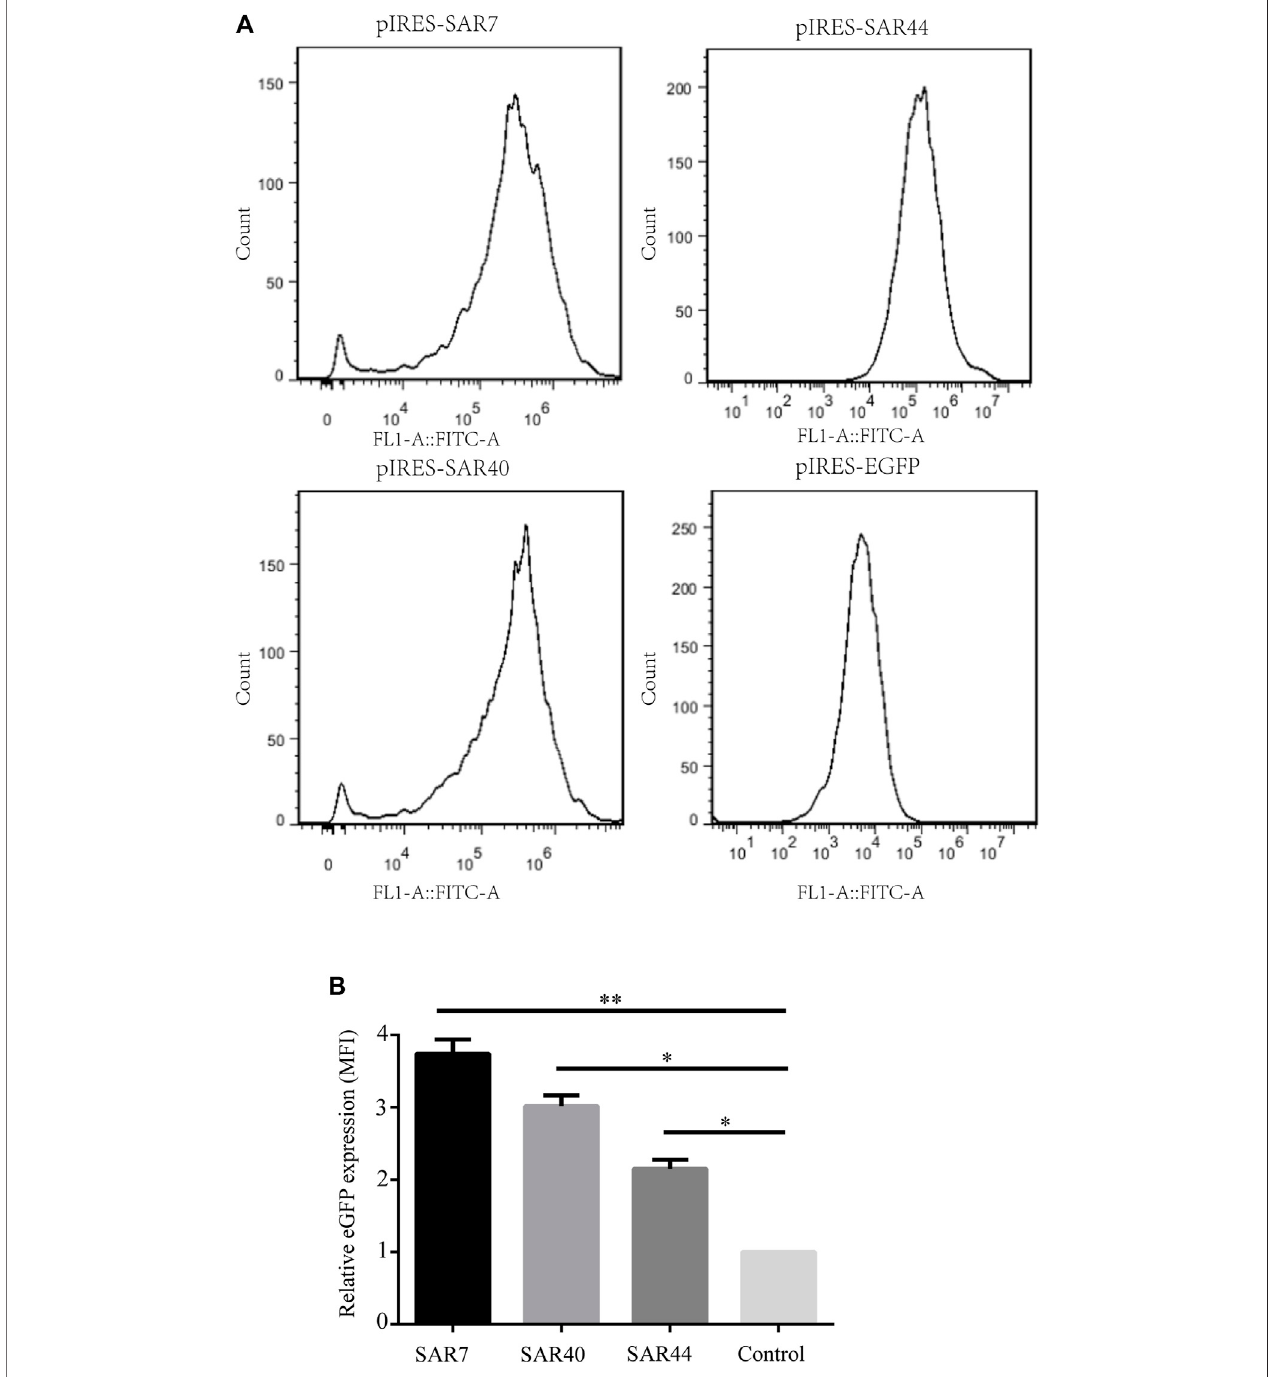
FIGURE 3 | Analysis of MFI in stably transfected CHO cell line. (A) The MFI of eGFP of the different construct was measured by fl ow cytometry on day 20 under G418 selection. (B) Fold statistical analysis results of eGFP expression levels in the different constructs. The results are the mean values obtained for three independent experiments, and the standard deviation is indicated (* p < 0.05; ** p <